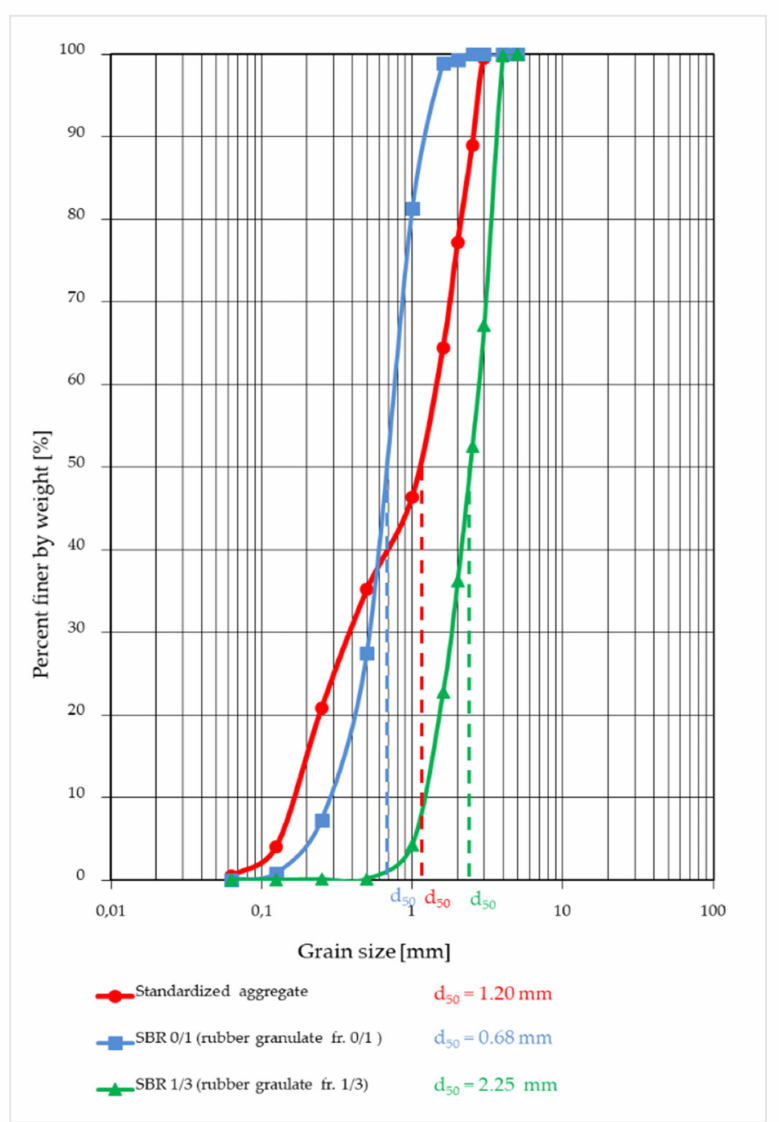
Figure 2. Grain size curve of standardized aggregate and rubber granulate fr. 0/1 mm, fr. 1/3